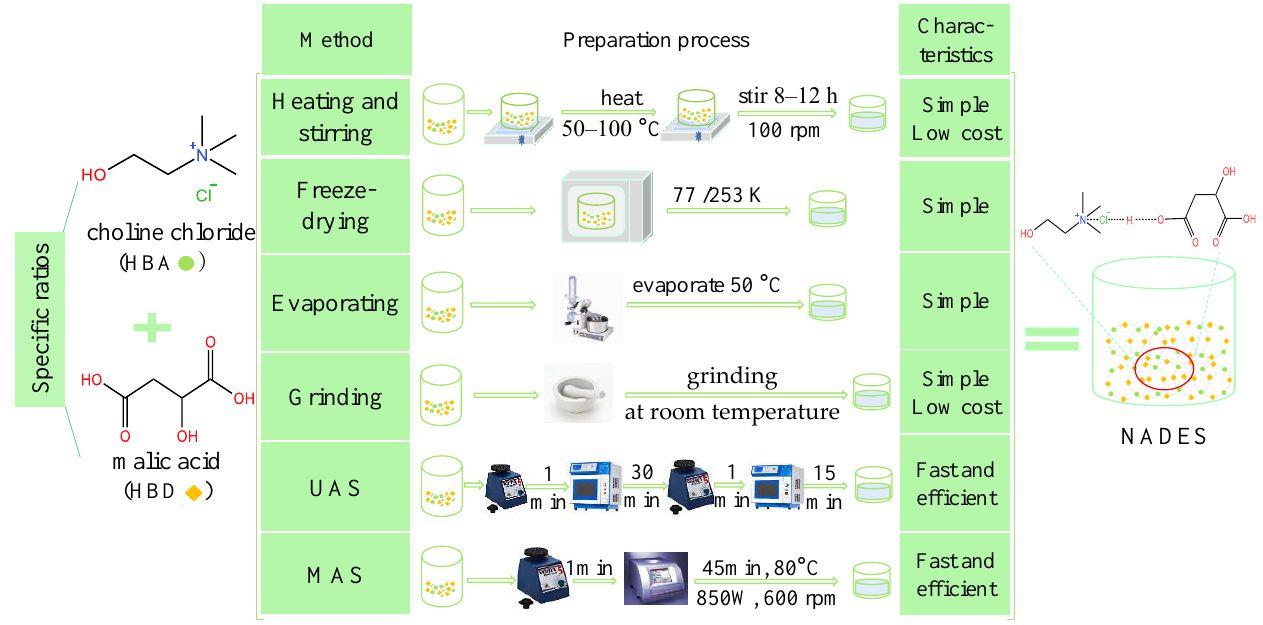
Figure 2. The preparation of NADES using choline chloride and malic acid by different methods [6,7,12 – 15].